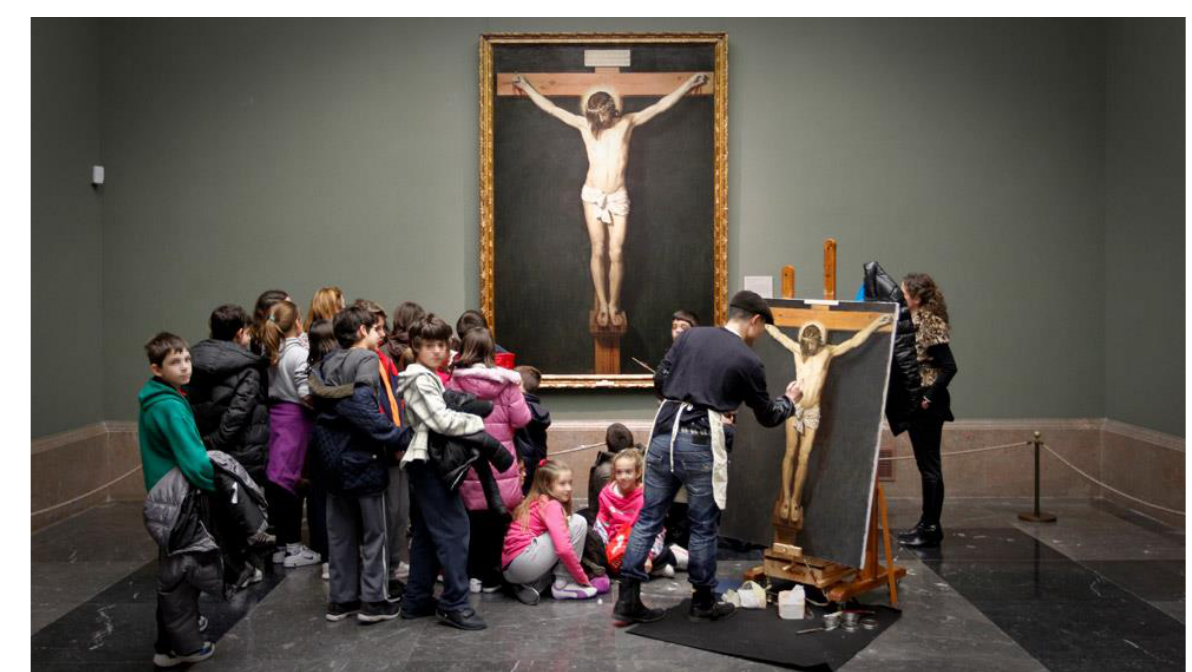
Figure 1. Caravaggio paintings, 17th century. Church of San Luigi dei Francesi, Rome, Italy. Photo in public domain.